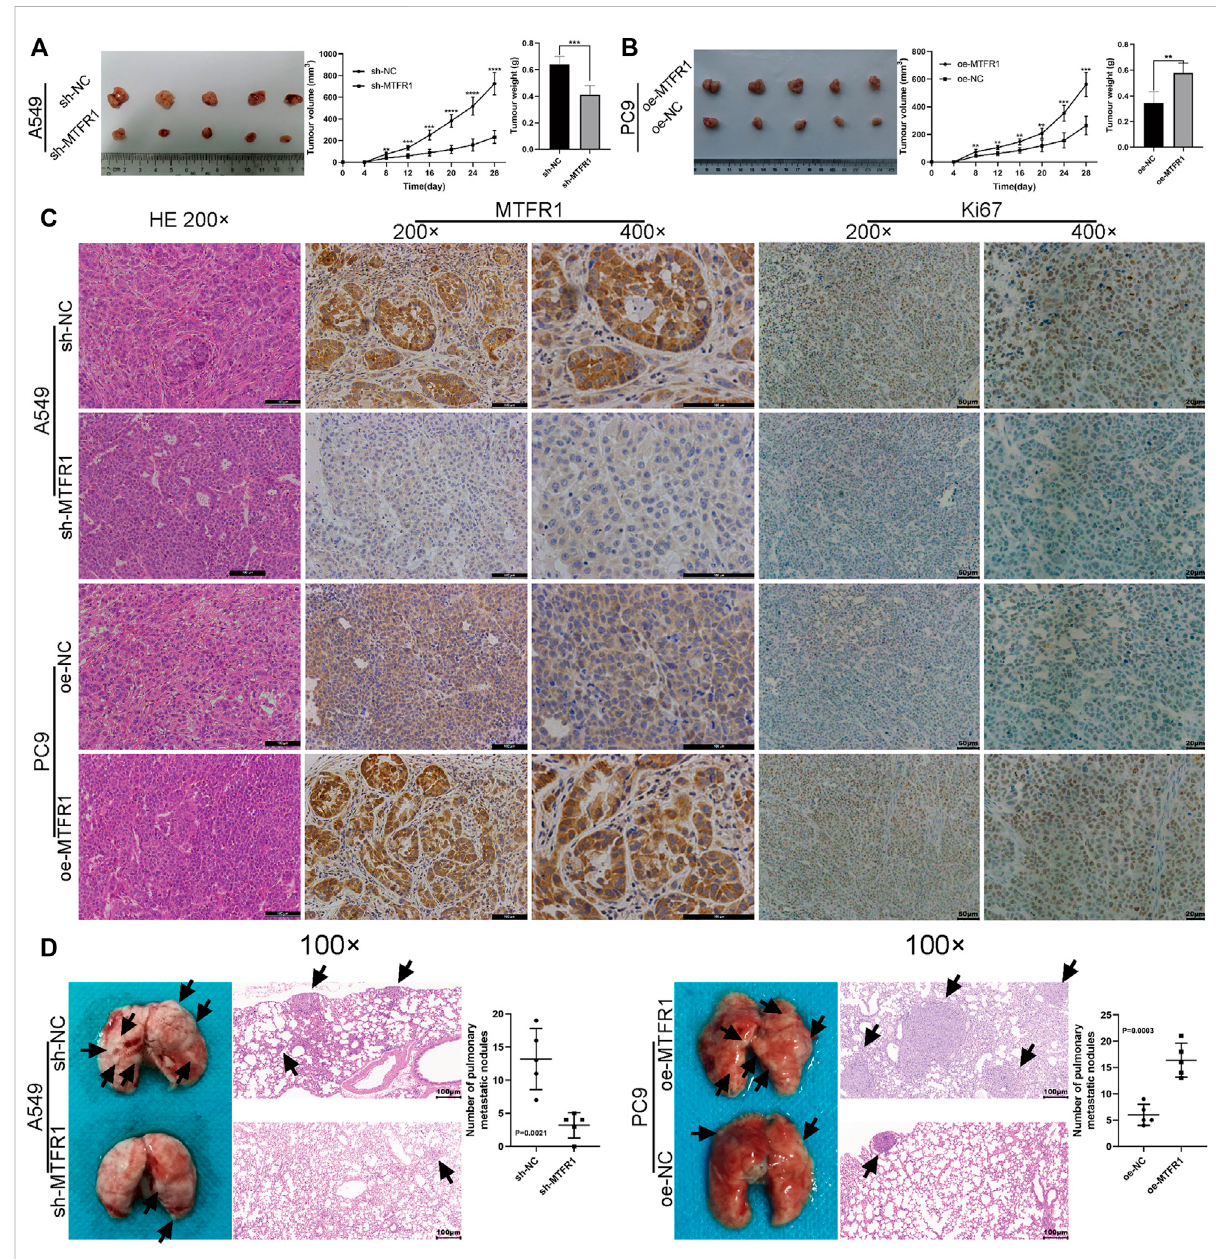
FIGURE 9 MTFR1 promoted the progression of LUAD cells in vivo . (A,B) Tumour images, tumour growth curves and tumour weights of each group. (C) Haematoxylin – eosin (HE) staining and immunohistochemical analysis of the Ki-67 and MTFR1 proteins of tumours in each group. (D) Photographs (left) and HE-stained images (right) of the lungs in each group; the black arrowheads denote lung metastasis nodules (** p < 0.01, *** p < 0.001, **** p <